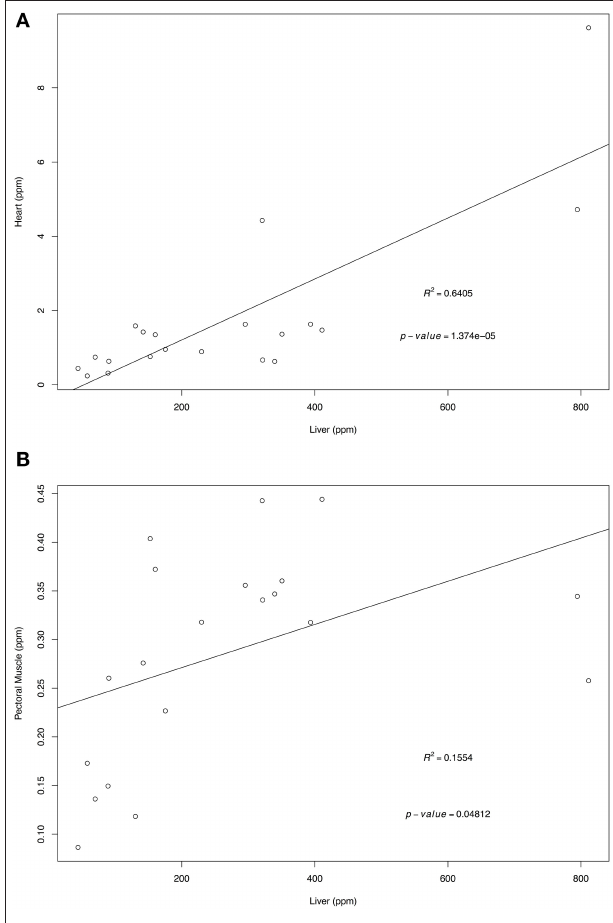
FIGURE 1 | Regression of liver retinol wet mass concentrations (ppm) on heart (A) and pectoral muscle (B) . Tissues samples were obtained from after-hatch year Anna’s Hummingbird carcasses ( n = 20). Samples were analyzed by high performance liquid